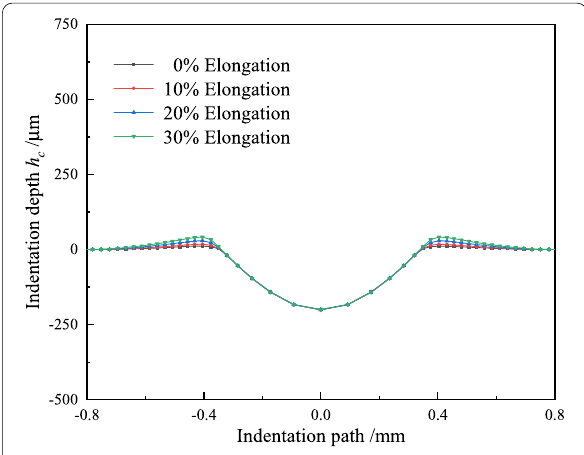
Figure 17 Comparison of maximum indentation morphology under different elongations